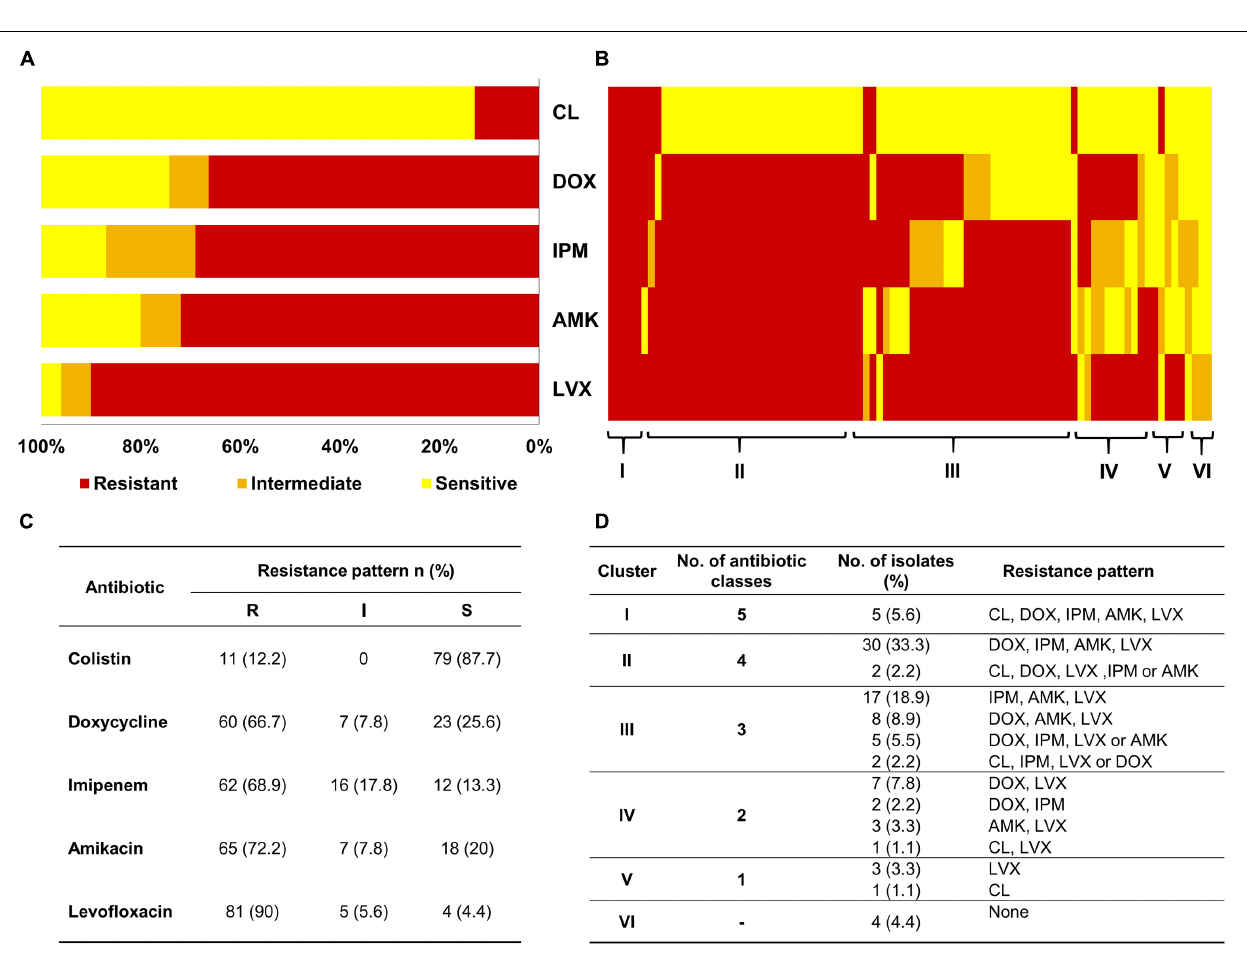
FIGURE 1 | Sensitivity of A. baumannii isolates ( n = 90) to different antibiotics as analyzed by MIC. (A) Stacked bar chart summarizing the resistance phenotypes of the 90 A. baumannii isolates to five antibiotics (y-axis). CL, colistin; DOX, doxycycline; IPM, imipenem; AMK, amikacin; LVX, levofloxacin. (B) Heatmap demonstrating the resistance pattern of each isolate as per the colors in the figure key (red, resistant; orange, intermediate; and yellow, sensitive). Isolates on the x-axis are sorted into six clusters footnoted on the heatmap. (C) Table summarizing the interpretation of MIC tests according to CLSI (2019). (D) Tabular representation of the detailed resistance patterns of the six clusters shown in Panel (B)